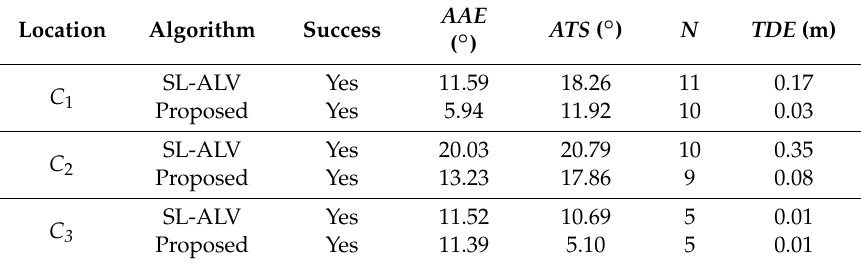
Table 4. Associated results of homing experiment 1.